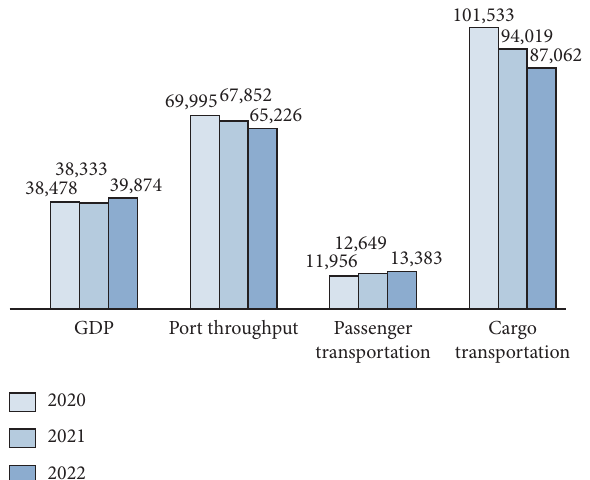
Figure 5: Simulation prediction when COVID-19 epidemic is